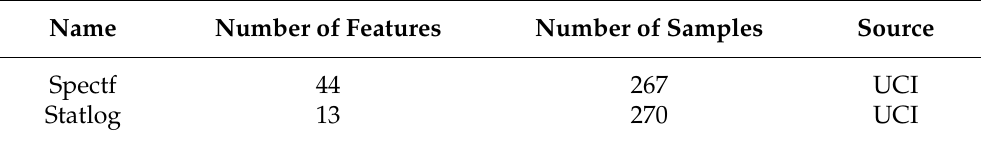
Table 1. Dataset